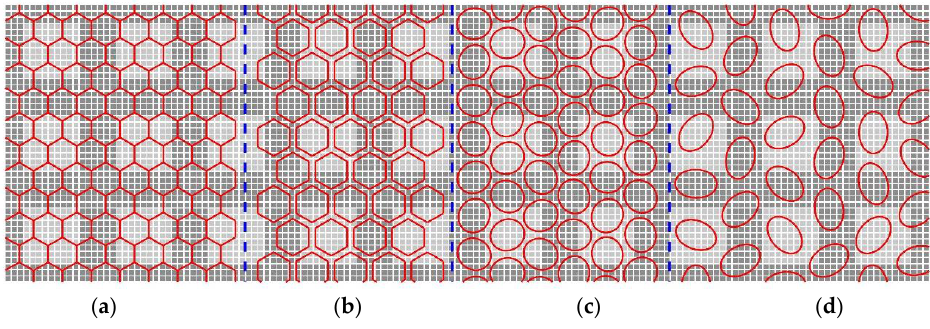
Figure 3. A simulated sensor structure according to the distribution of photoreceptors in retina of the eye. Each area of ( a – d ) corresponds to each segment of ( a – d ) in Figure 2.